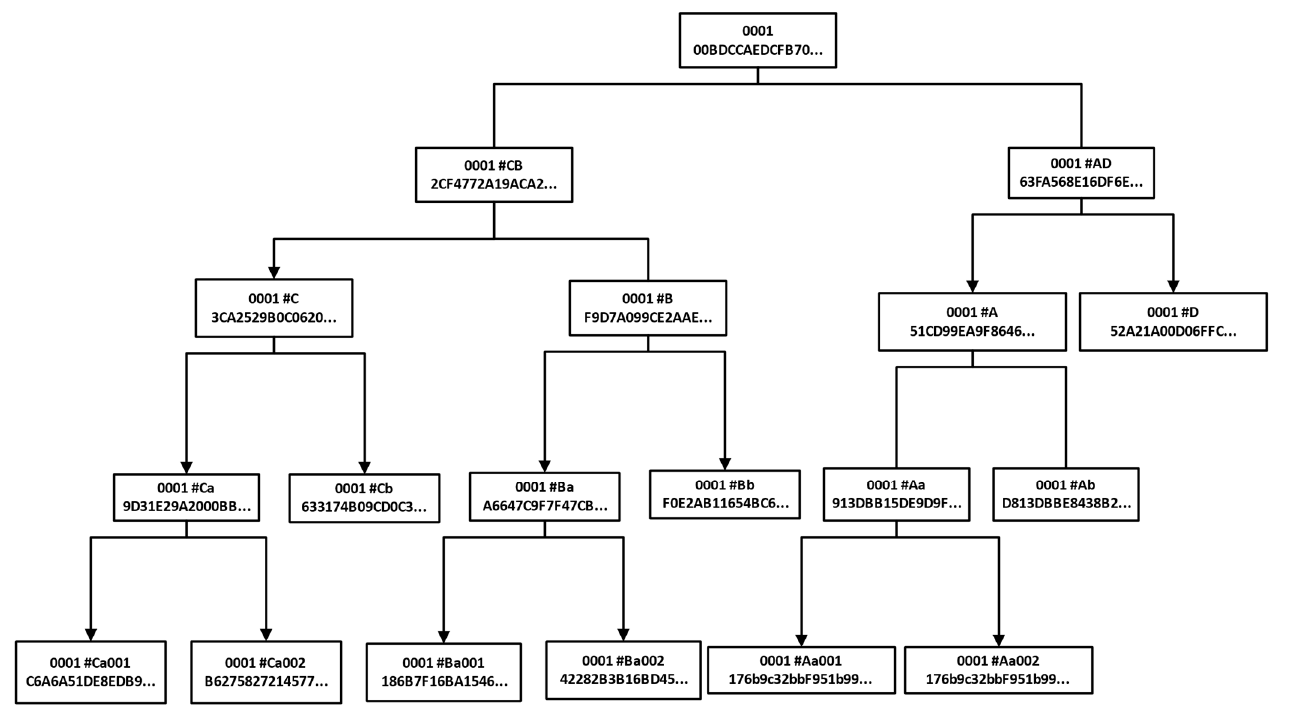
Figure 8. Merkel tree structure diagram of stored data.